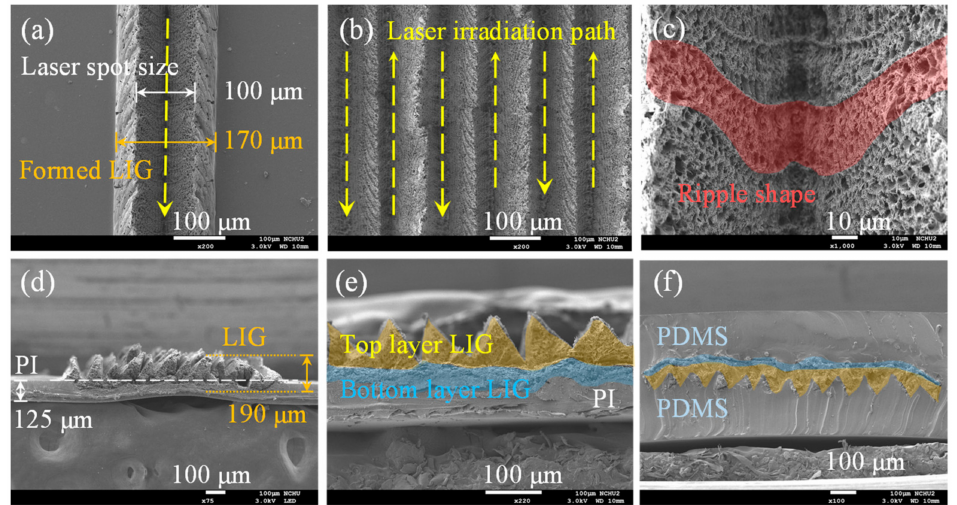
Figure 6. SEM images of ( a – e ) LIG structures formed by laser irradiation and ( f ) transfer of the LIG structure and packaging with